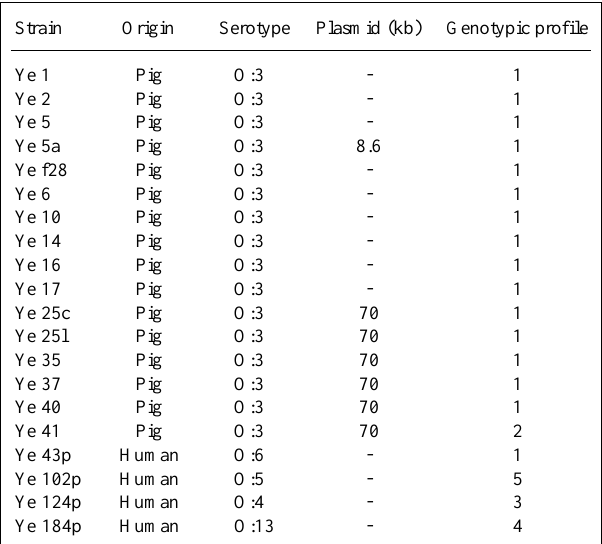
Table I - Phenotypic characteristics of Yersinia enterocolitica strains and their genotypic profiles distinguished by RAPD-PCR.